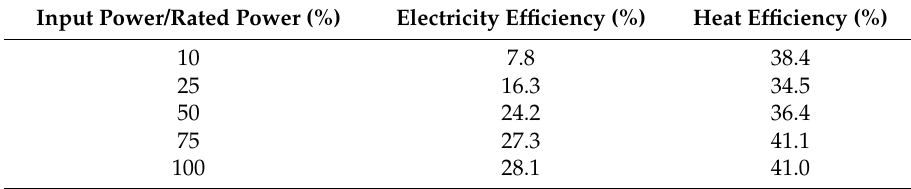
Table 1. Output efficiencies of the combined heat and power (CHP) for different input power